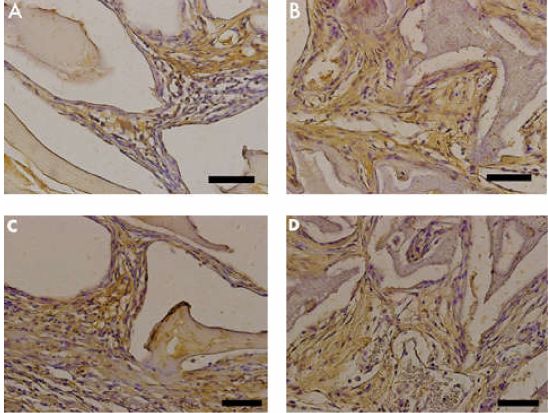
Figure9. Photomicrographsofmetalloproteinase(MMP)-9stainedslides. Browncolorindicatesosteoblastic activity. ( A,C ) Group 1 (bone xenograft), ( B,D ) Group 2 (nano-hydroxyapatite / beta-tricalcium phosphate composite). Scale bar = 100 µ m, 400 ×